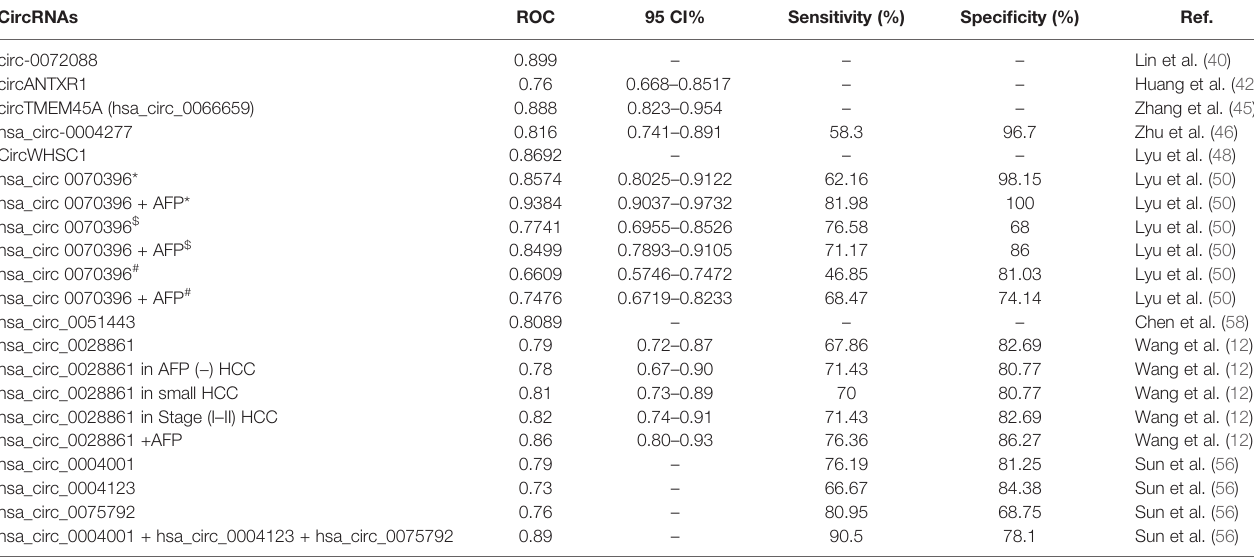
TABLE 3 | Exosomal circRNAs serve as potential diagnostic biomarkers for HCC.